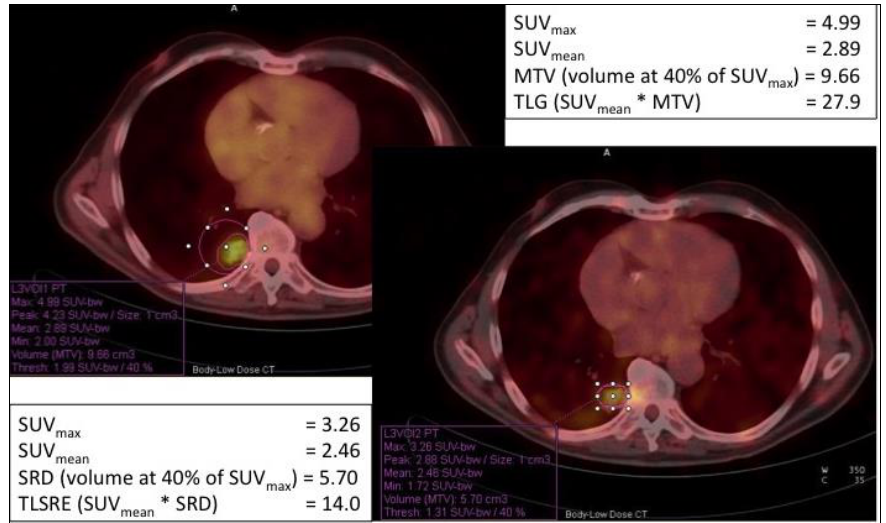
Figure 5. New evaluation prognostic parameters for NETs comparing [ 18 F]-FDG PET/CT (left image) and [ 68 Ga]-DOTA-NOC imaging (right image). The same lesion was analyzed by both [ 18 F]-FDG and [ 68 Ga]-DOTA-NOC, measuring SUV max , SUV mean for both PET scans, MTV and TLG for [ 18 F]-FDG, SRD and TLSRE for [ 68 Ga]-DOTA-NOC. Considering the same volume of lesion, TLG and TLSRE values reported differential expression of SSTR and glucose transporters (GLUT) in the lesion. SUV = Standard Uptake Value; MTV = Metabolic Tumor Volume; TLG = Total Lesion Glycolysis; SRD = Somatostatin Receptor Density; TLSRE = Total Lesion Somatostatin Receptor Expression.